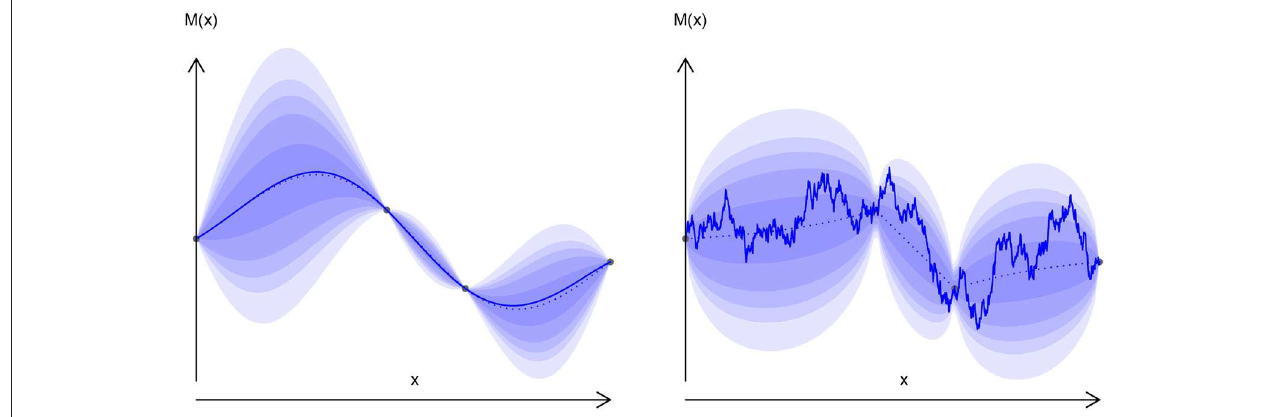
FIGURE 4 | Exponential (right) and gauss (left) kernels random processes. Plain line: one sample drawing, dotted line: mean value, blurred zone: quantiles.